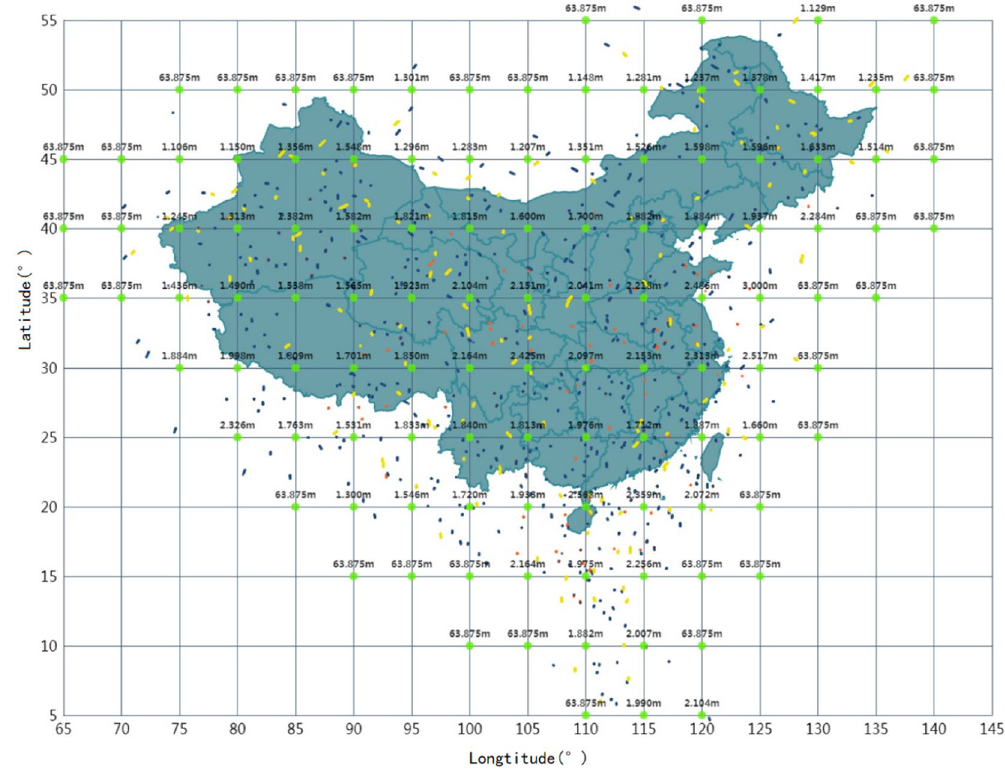
Figure 6. Ionospheric correction values of the fixed IGPs. The available value of the ionospheric correction parameters is about 2 m around the BDSBAS service area, and the default value of the ionospheric correction parameter is 63.875 m when it cannot be calculated.